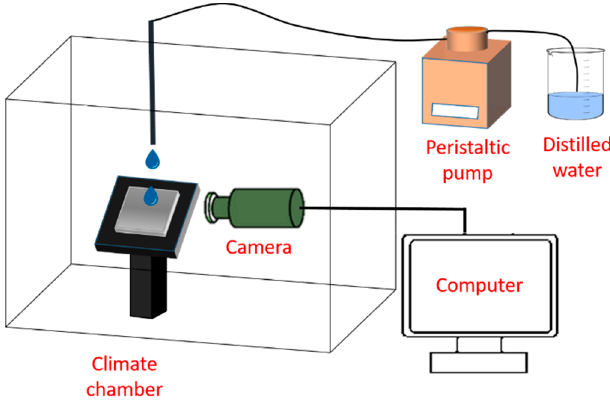
Figure 1. Schematic of the water dripping test performed in the climate chamber at − 20 °C.